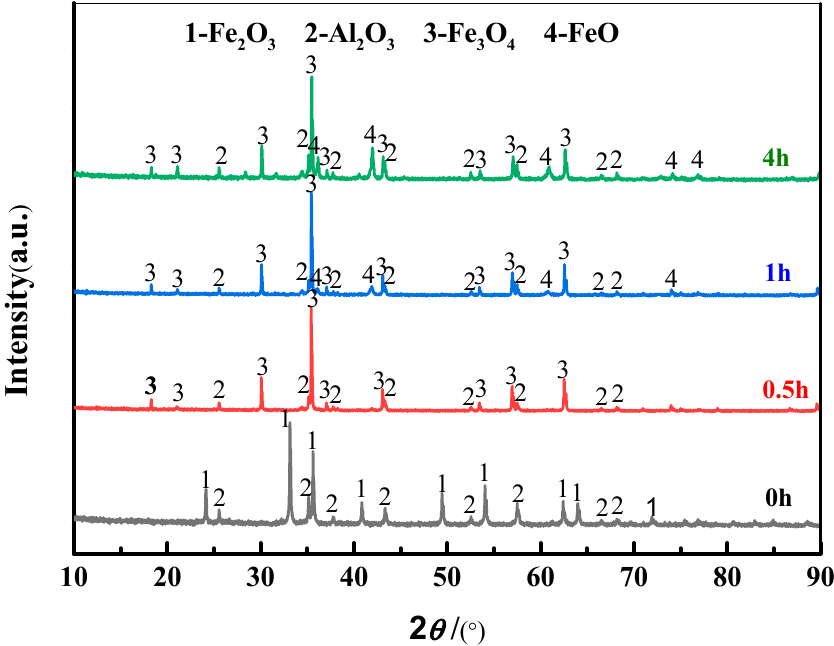
Figure 8. XRD patterns of S 2 (mFe 2 O 3 /mAl 2 O 3 = 3:2, at 2.3 V, 850 °C) at different times.